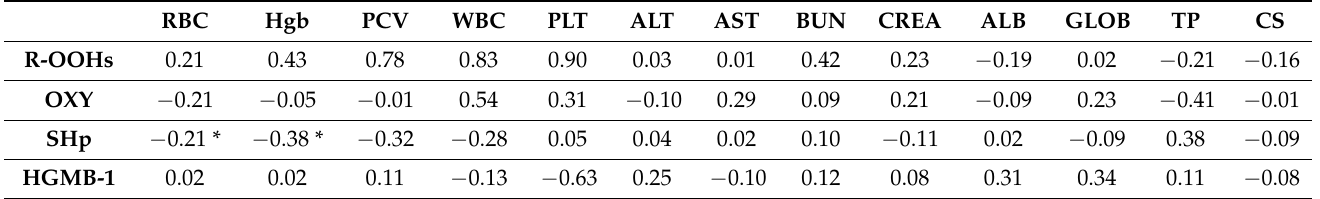
Table 5. Correlation between oxidative stress, hematochemical variables, and the clinical score in the G1 group (Spearman’s rank order) (* p <